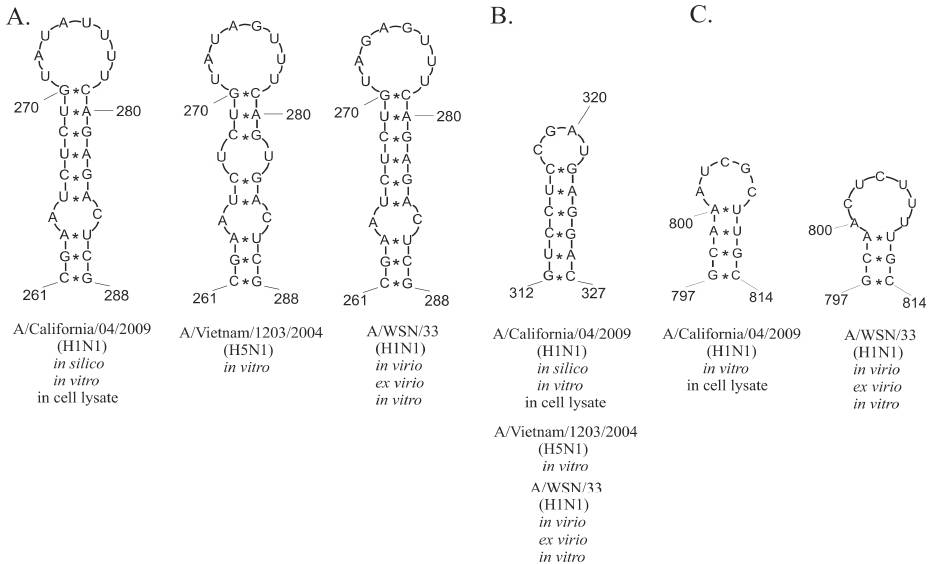
Figure 9. Conserved structural motifs of vRNA8 within different IAV strains. The motifs were predicted based on bioinformatics analysis and chemical probing experiments in different conditions.